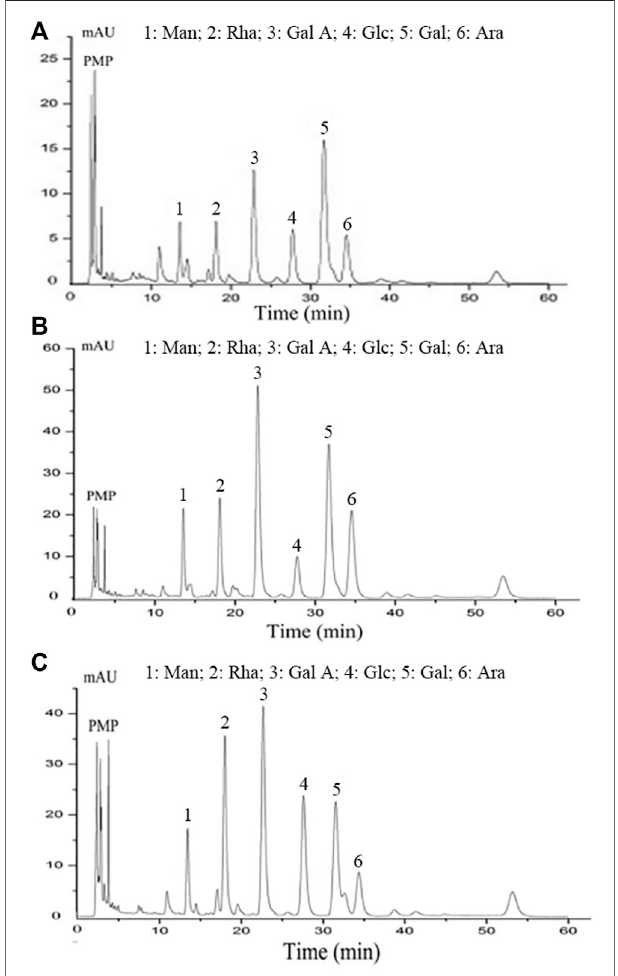
FIGURE 3 | Monosaccharide composition analysis of polysaccharides isolated from P. cablin : (A) Monosaccharide composition of PCB; (B) Monosaccharide composition of PCB-1; (C) Monosaccharide composition of PCB2-1. PMP-labeled and analysed by HPLC.